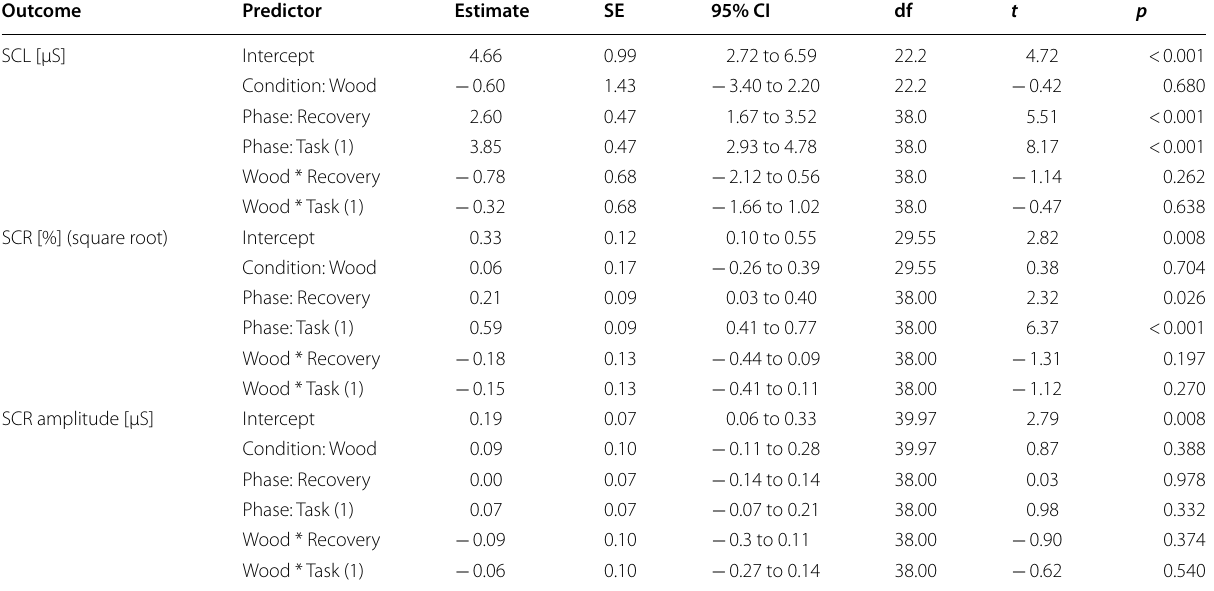
Table 2 Results of the linear mixed models with electrodermal activity parameters as dependent variables